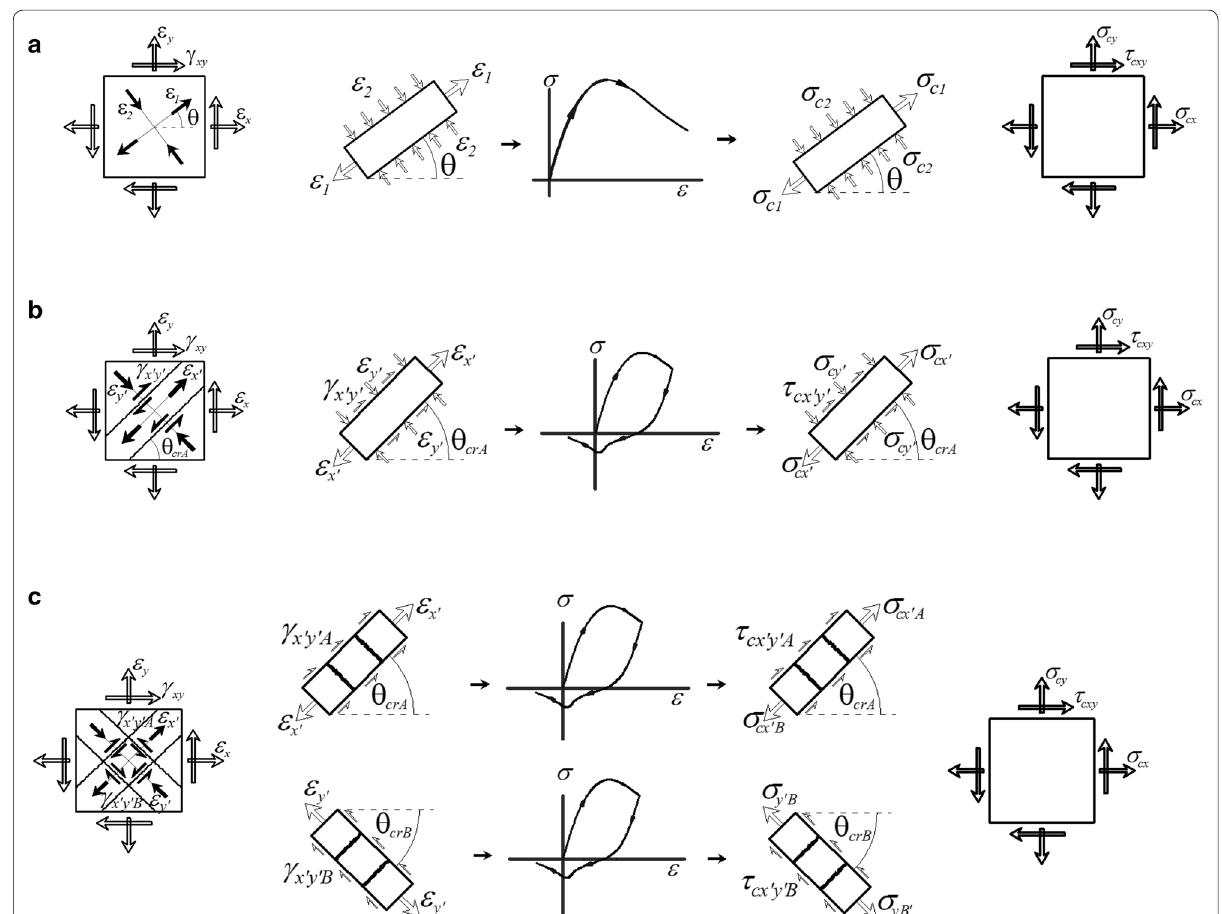
Fig. 1 Concrete behavior in FSAM: a uncracked, b after formation of first crack, c after formation of second